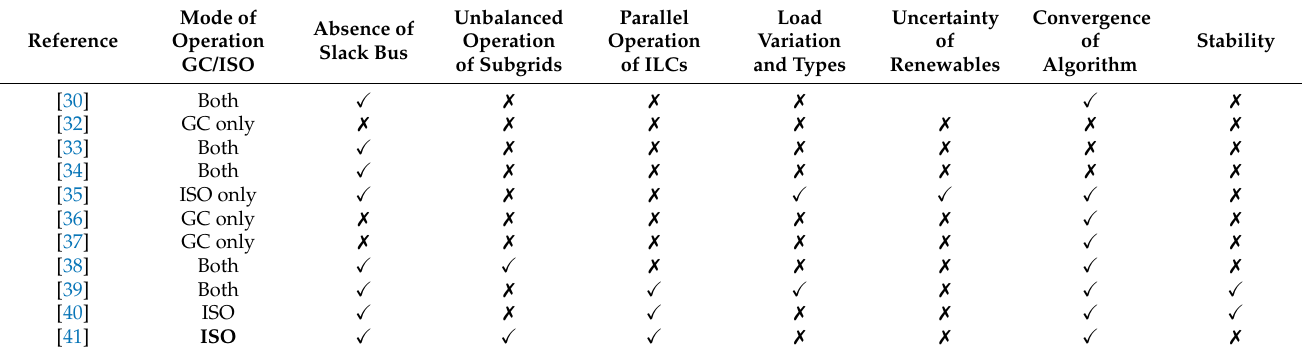
Table 1. Review table of power flow analysis for a hybrid